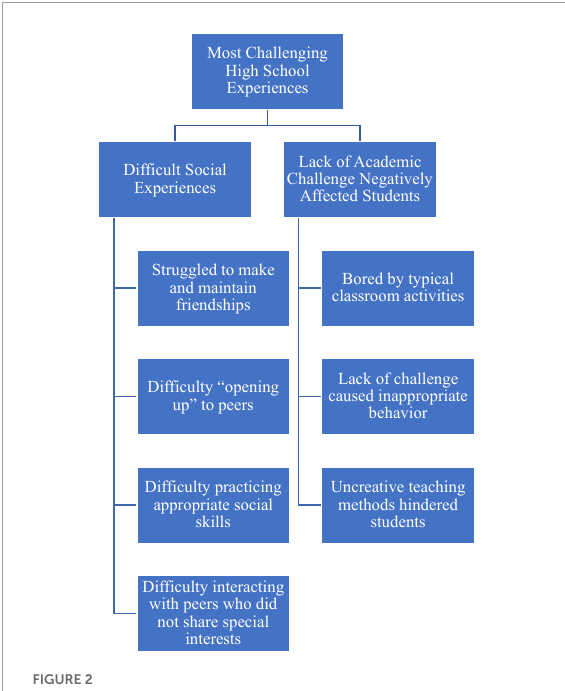
FIGURE2 Coding map of the most challenging high school experiences.